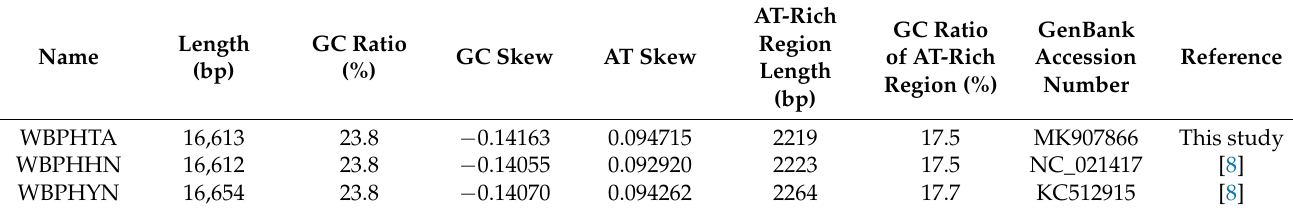
Figure 1. Complete WBPHTA mitochondrial genome sequence. Black circle indicates the WBPHTA mitogenome, yellow bars are protein-coding genes, purple bars are tRNAs, and red bars mean rRNAs. Each gene name was displayed with lines directing to the corresponded bars. Table 1. Characteristics of three available WBPH mitogenomes.